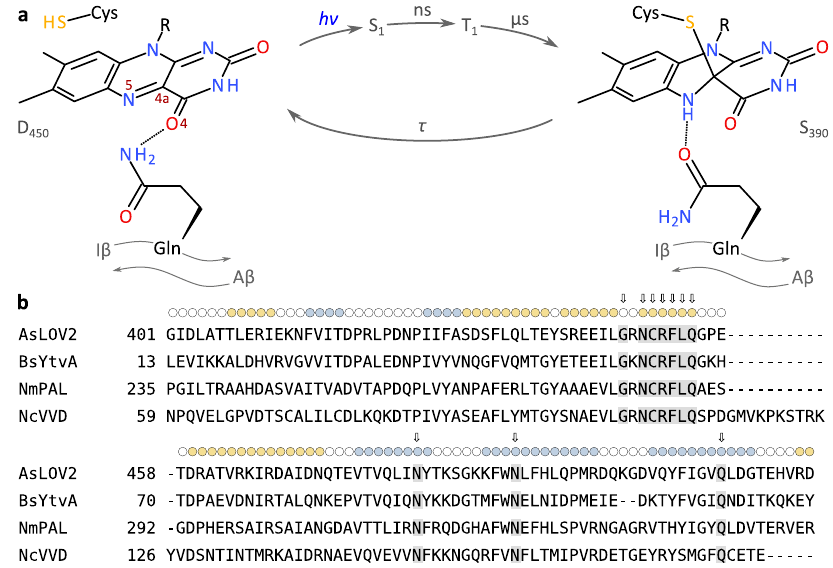
Fig. 1 Photochemistry of light-oxygen-voltage receptors and sequences of proteins under study. a Photocycle of light-oxygen-voltage (LOV) receptors. Absorption of blue light by the dark-adapted state (D 450 ) prompts the LOV receptor to traverse short-lived excited singlet (S 1 ) and triplet (T 1 ) states before assuming the light-adapted state (S 390 ), which is characterized by a thioadduct between the fl avin atom C4a and the sidechain of a conserved cysteine. Adduct formation goes along with protonation of the N5 atom which entails changes in hydrogen bonding within the LOV receptor, particularly of a conserved glutamine residue situated in strand I β of an antiparallel β -pleated sheet. The light-adapted state passively decays to the dark-adapted state over a matter of seconds to hours, depending on the fl avin surroundings. b Multiple sequence alignment of A. sativa phototropin 1 LOV2 ( As LOV2) 15 , B. subtilis YtvA LOV ( Bs YtvA) 94 , N. multipartita PAL LOV ( Nm PAL) 46 , and N. crassa Vivid LOV ( Nc VVD) 59 . The secondary structure, as observed in As LOV2 47 , is indicated on top, with α helices in tan and β strands in blue. Residues strongly conserved across LOV receptors 62 are highlighted by arrows and gray